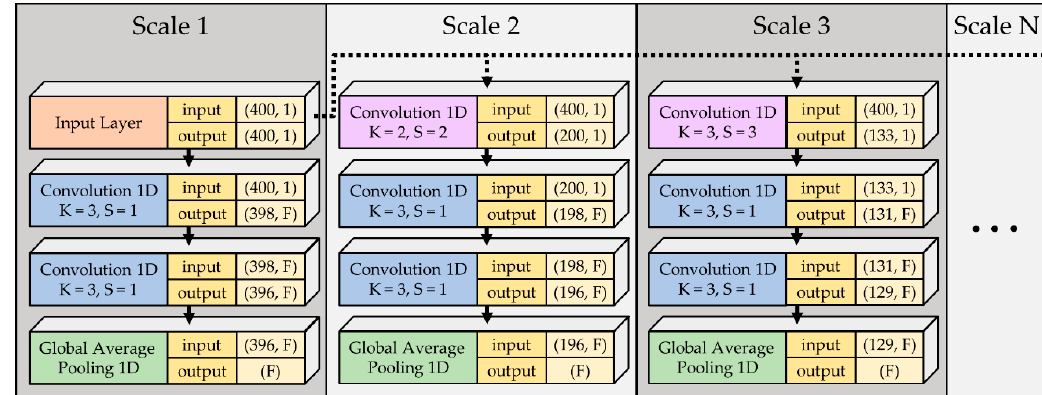
Figure 6. Multi-scale features-concatenate network in every lead branch. K represents kernel size, S represents strides. The N-Net only contained structures illustrated in scale 1, and MSN-Net that used two scales will contain the structure of both scale 1 and scale 2. MSN-Net that used three scales contained structures of scale 1, scale 2 and scale 3, and so on.